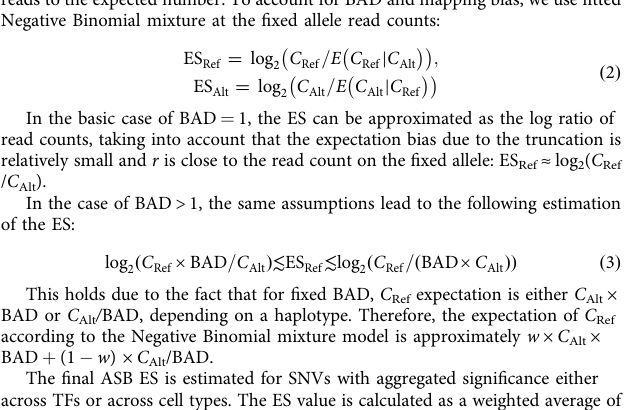
Fig. 6 Distribution of read counts at SNVs signi fi cantly depends on background allelic dosage. Each panel contains three plots: (1, left) a heatmap of allelic read counts colored by log 10 [number of SNVs that have the speci fi ed number of ChIP-Seq reads] supporting the reference ( X -axis) and alternative ( Y -axis) alleles; (2, middle, 3, right) barplots of observed read counts at one of the alleles and the approximating distribution plot. Two barplots correspond to the two slices of the heatmap data, either by fi xing the sum of reads at two alleles ( a – d , diagonal slices along the dashed lines in the bottom left corner, approximated by the binomial mixture) or by fi xing the read counts at one of the alleles ( e , f , vertical and horizontal slices, approximated by the negative binomial mixture). a Complete set of ADASTRA candidate ASB SNVs, no separation by BAD, the observed distribution can be interpreted as overdispersed binomial. b K562 candidate SNVs, the distribution is similar to an overdispersed mixture of binomial distributions with p ¼ 1 = 3 and p ¼ 2 = 3 as K562 are mostly triploid. c SNVs in diploid regions according to BAD = 1, binomial distribution with p ¼ 1 = 2 . d SNVs in BAD-separated triploid regions (BAD = 2), binomial mixture with p ¼ 1 = 3 and p ¼ 2 = 3 . e BAD-separated diploids (BAD = 1), negative binomial distribution with p ¼ 1 = 1 ( fi t). f BAD-separated triploids (BAD = 2), negative binomial mixture with p ¼ 1 = 3 and p ¼ 2 = 3 ( fi t). In all the cases the distributions are truncated, corresponding to the allelic read